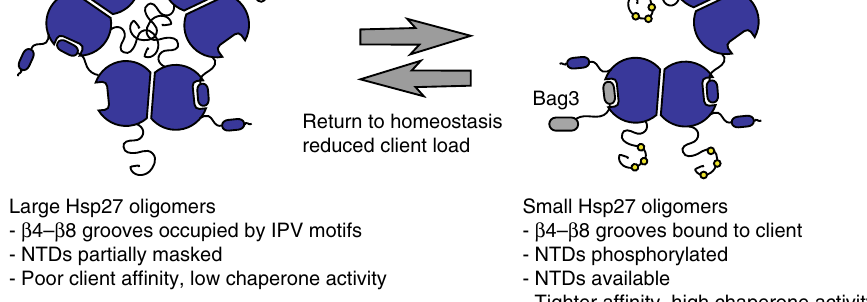
Fig. 6 Schematic model for the activation of Hsp27. a Major domains of Hsp27, highlighting the sites of protein-protein interactions (PPIs). b Schematic summary of the model. Large Hsp27 oligomers are held together by multiple PPIs: (i) ACD – ACD interactions, (ii) self-limiting IPV contacts between dimers, and (iii) NTD interactions. Under conditions of stress, phosphorylation of the NTD, combined with competitive interactions for the β 4 – β 8 grooves, drives oligomer disassembly and reveals the active NTDs. The contact with tau takes place within the aggregation-prone regions of the microtubule- binding repeats (red), while Bag3 uses its own IPV motifs (gray). When conditions improve, the restored self-IPV contacts would reset the system and release the client (i.e., tau). In this model, we do not want to imply any speci fi c oligomerization state; rather, the simple trimer is used to represent